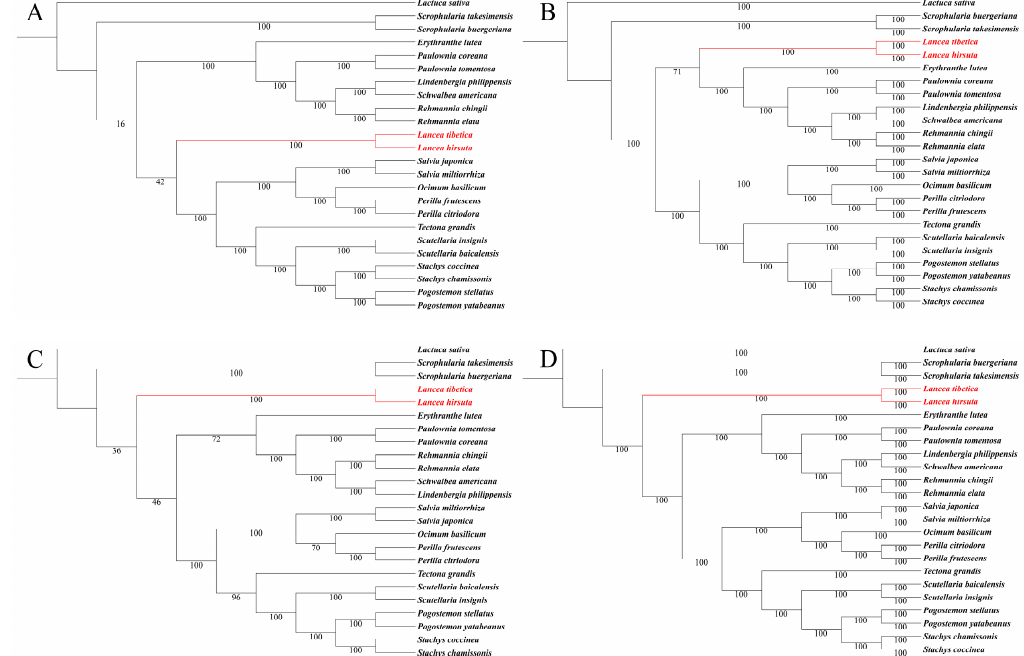
Figure 6. Phylogenetic trees of 24 species based on complete chloroplast genomes and 75 protein-coding genes. ( A ) Maximum likelihood (ML) phylogenetic tree constructed with complete chloroplast genomes; ( B ) Bayesian inference (BI) phylogenetic tree constructed with complete chloroplast genomes; ( C ) ML phylogenetic tree constructed with 75 protein-coding genes; ( D ) BI phylogenetic tree constructed with 75 protein-coding genes. The Lancea species are shown in red.